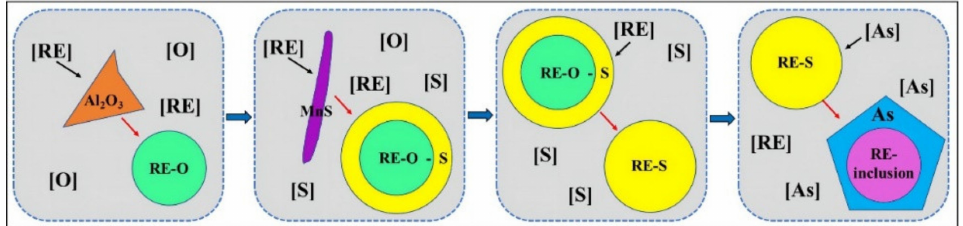
Figure 7. Schematic of the evolution process of inclusions in the steel during the rare earth modification